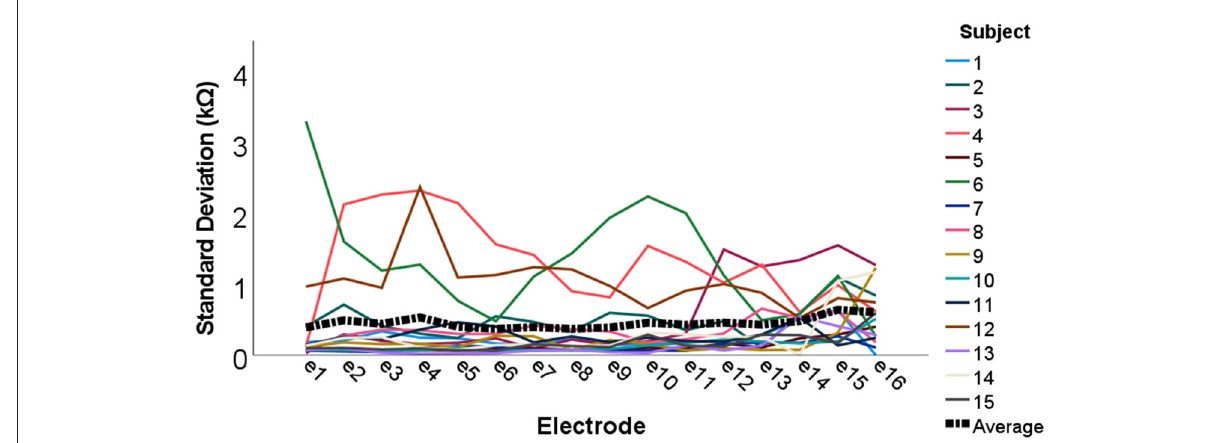
FIGURE3 Individual and group level electrode impedance standard deviations plotted across the electrode array. Colored lines represent each individual participant ( N = 15), and the black dotted line shows group average standard deviations.